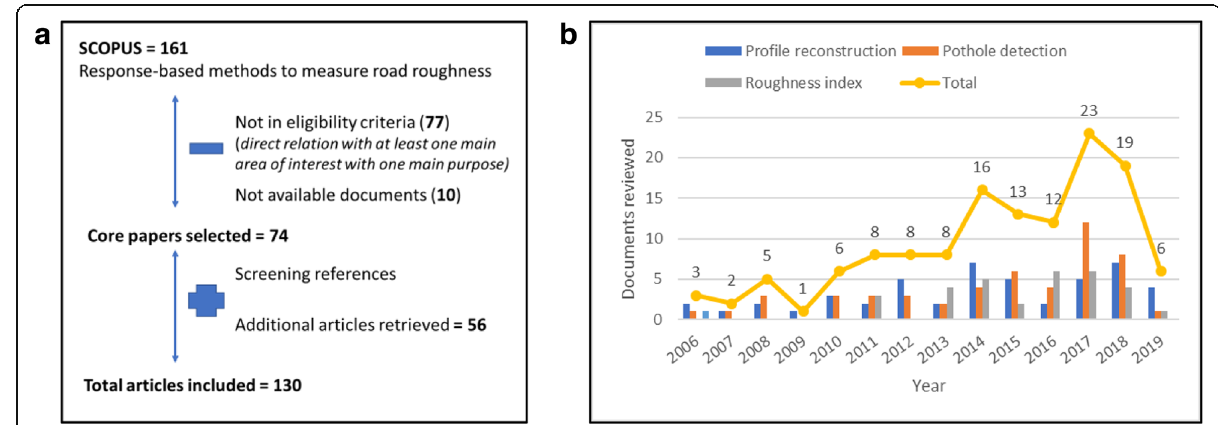
Fig. 3 Reviewed documents from ( a ) retrieval of 130 articles, and ( b ) development by